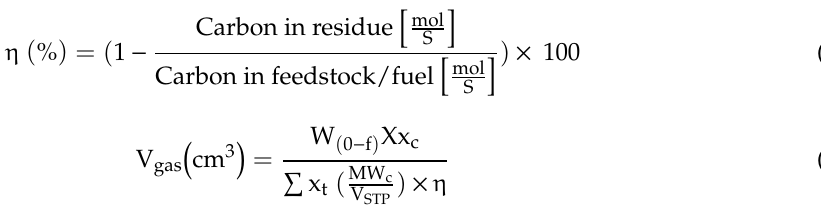
Proximate analysis (% w / w